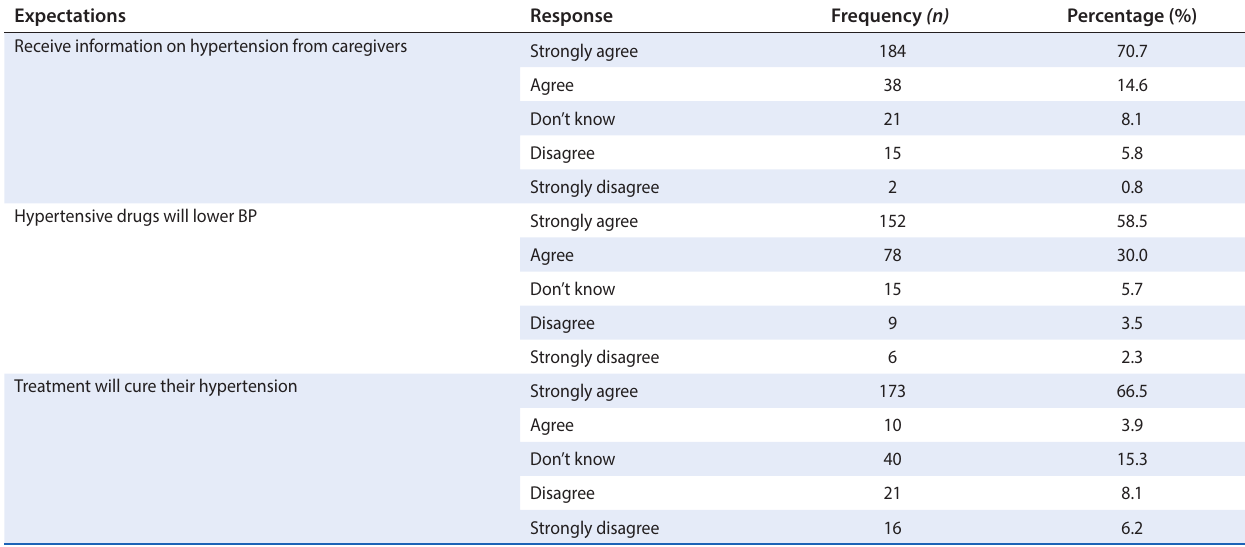
Table 2: The pattern of hypertensive patients’/respondents’ expectations Expectations